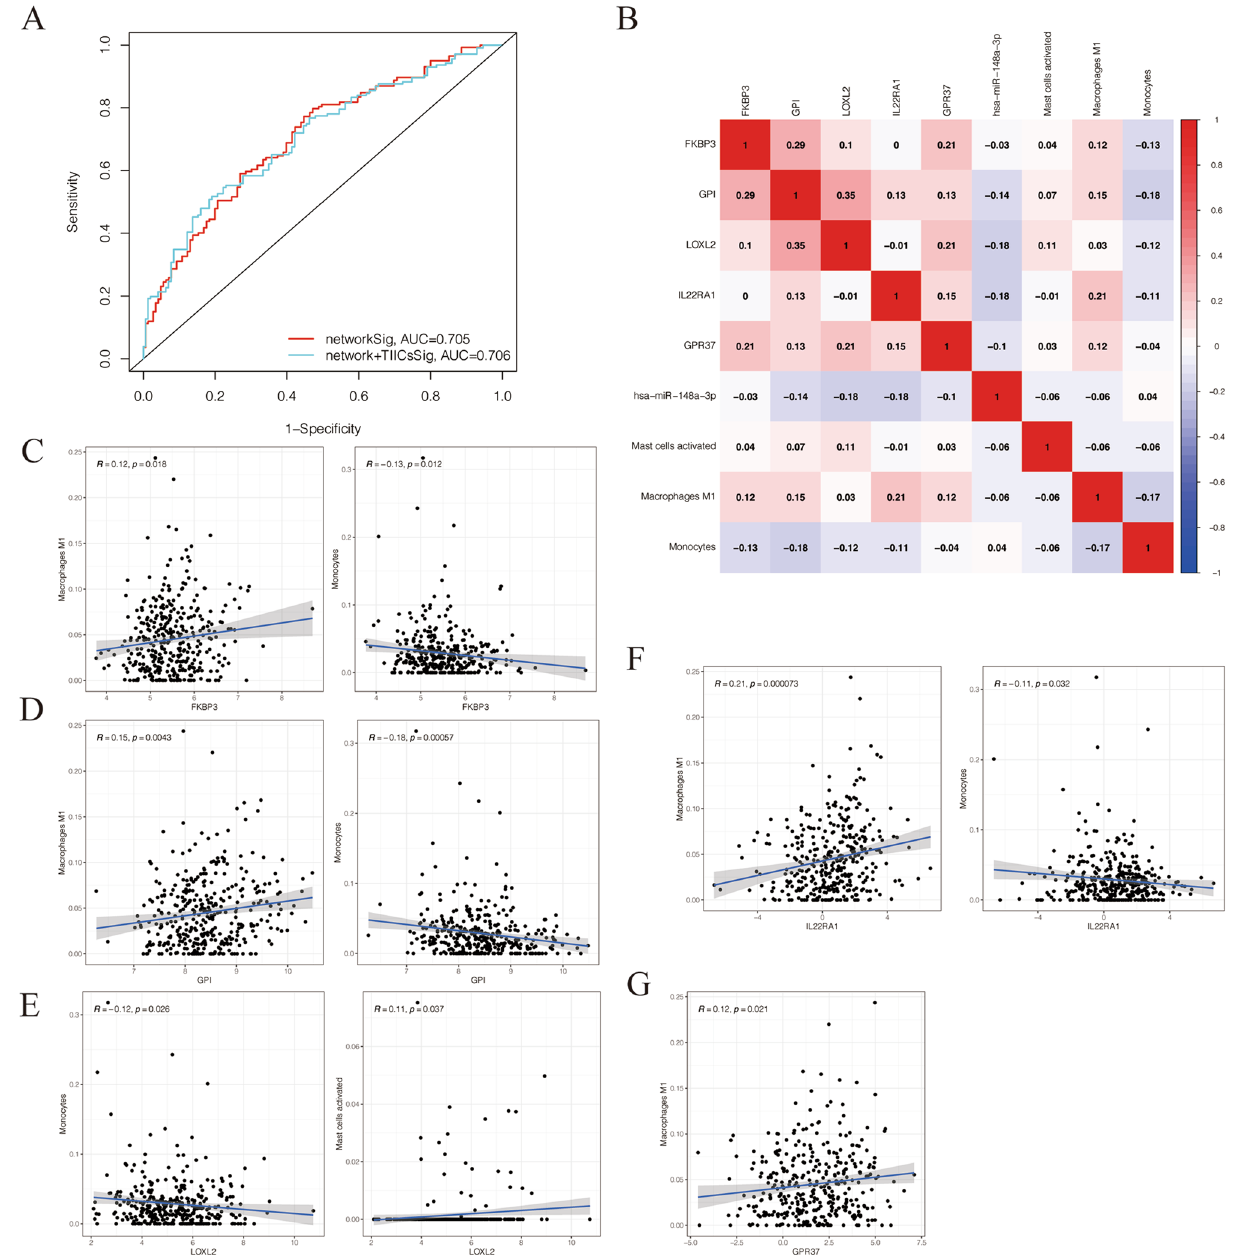
Figure 8. Correlation analysis between the key genes of ceRNA network and the prognostic immune cells. ( A ) The ROC curves of the ceRNA network signatures and ceRNA network combined TIICs signatures. ( B ) The co-expression heatmap of all key genes and the prognostic immune cells. ( C ) The FKBP3 was associated with Monocytes and Macrophages M1. ( D ) The GPI was associated with Monocytes and Macrophages M1. ( E ) The LOXL2 was negatively associated with Monocytes and Activated mast cells. ( F ) The IL22RA1 was related with Monocytes and Macrophages M1. ( G ) The GPR37 was associated with Macrophages M1. R, correlation coefficients. p -value <